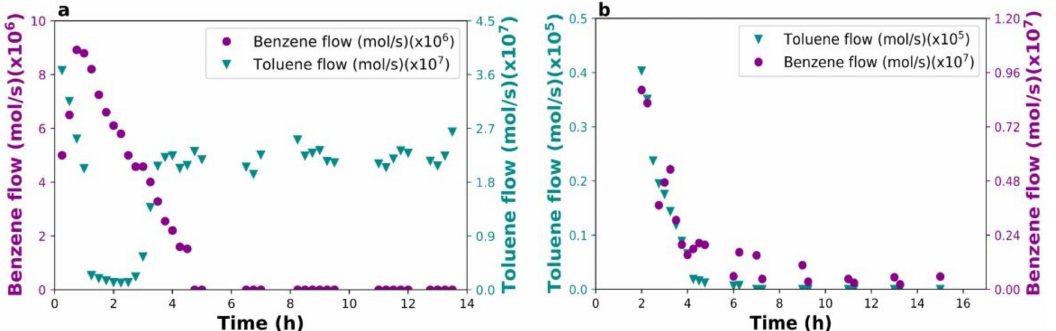
Figure 3. Tar model decomposition: ( a ) toluene (1979 ppm) decomposition over Fe/CAG catalyst, ( b ) benzene (1175 ppm) decomposition over Fe/CAG catalyst; temperature, 600 ◦ C; space velocity, 350 mL/(min · g cat